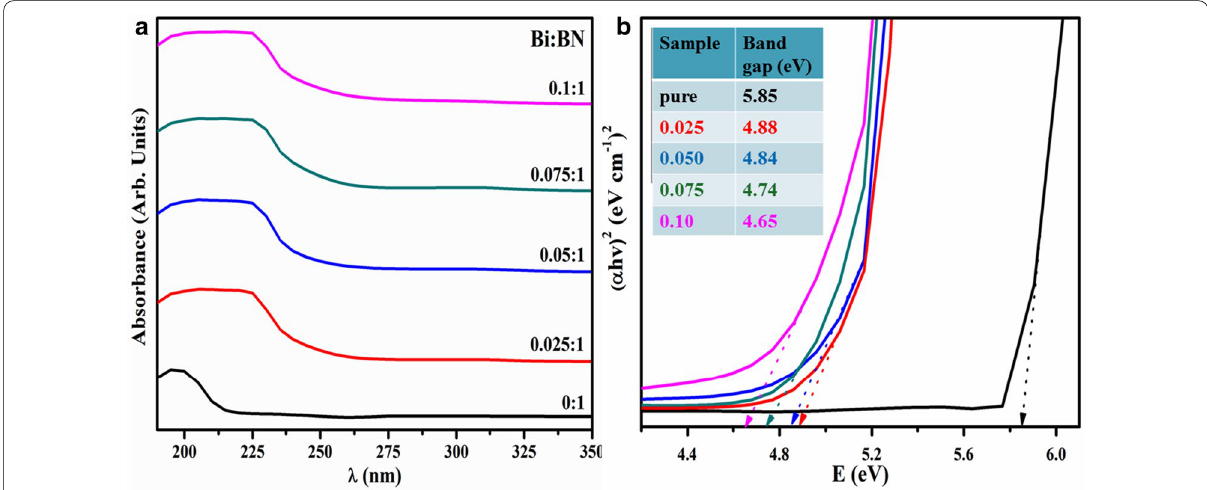
Fig. 3 a UV–Vis spectra of host and Bi‑doped BN nanosheets; b bandgap energy analysis using Tauc